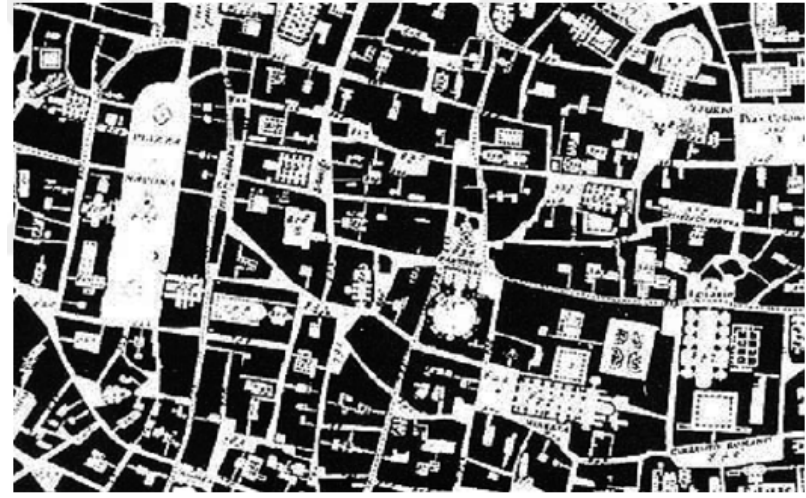
Figure 3 Italian architect Nolli’s map of Rome (Trancik, 1986)